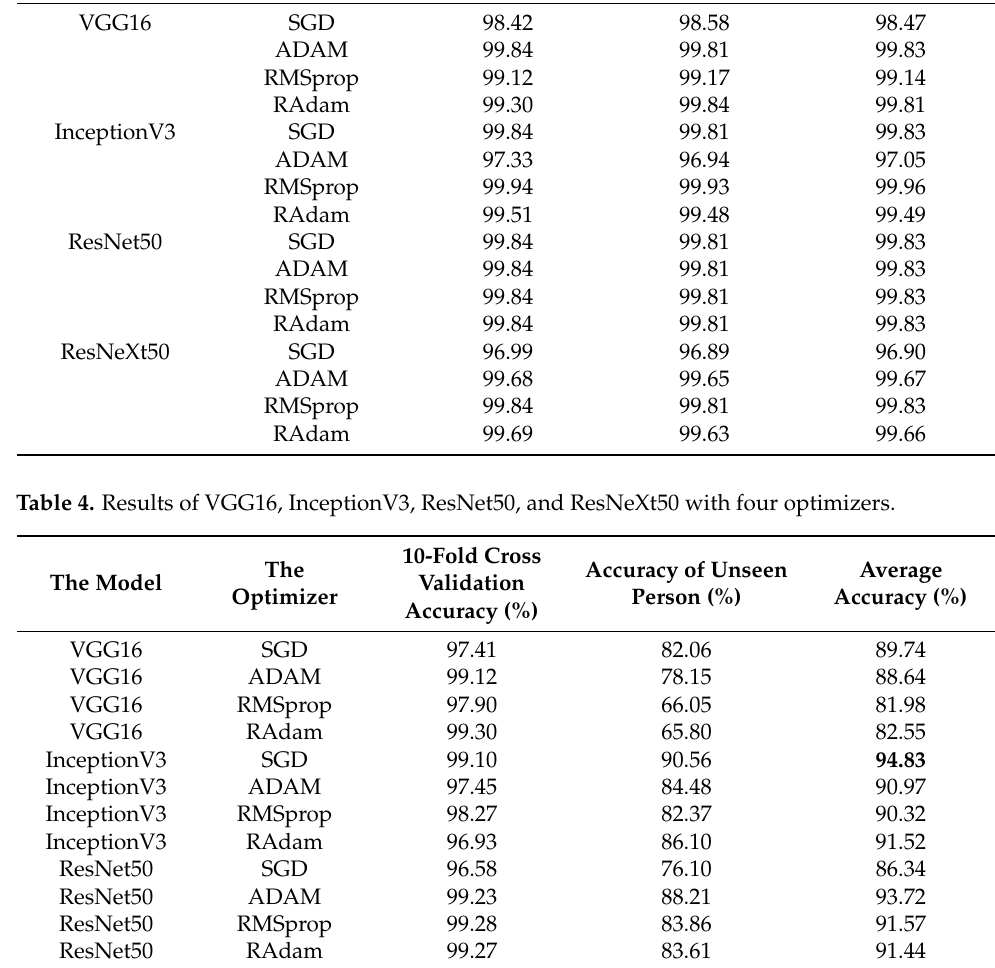
Table 3. The 10-fold cross validation results of VGG16, InceptionV3, ResNet50, and ResNeXt50 with four optimizers.